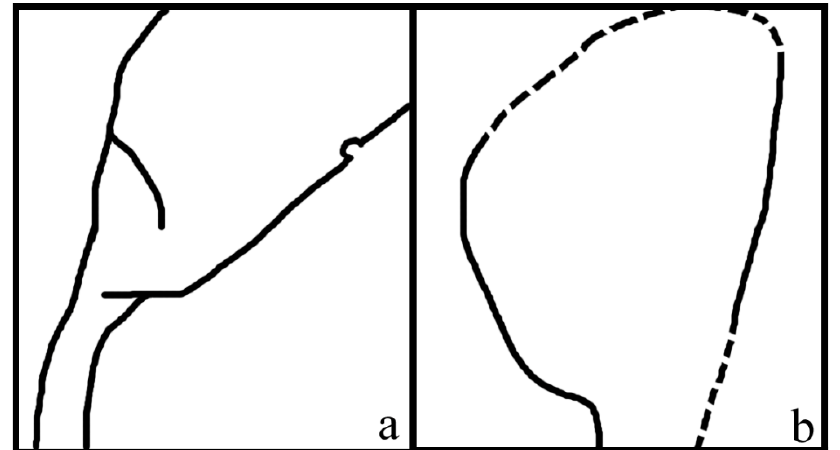
Figure 3. Sketches of Combina . ( a ). Asymmetrical ovule base in Figure 1i. ( b ). Asymmetrical ovule base in Figure